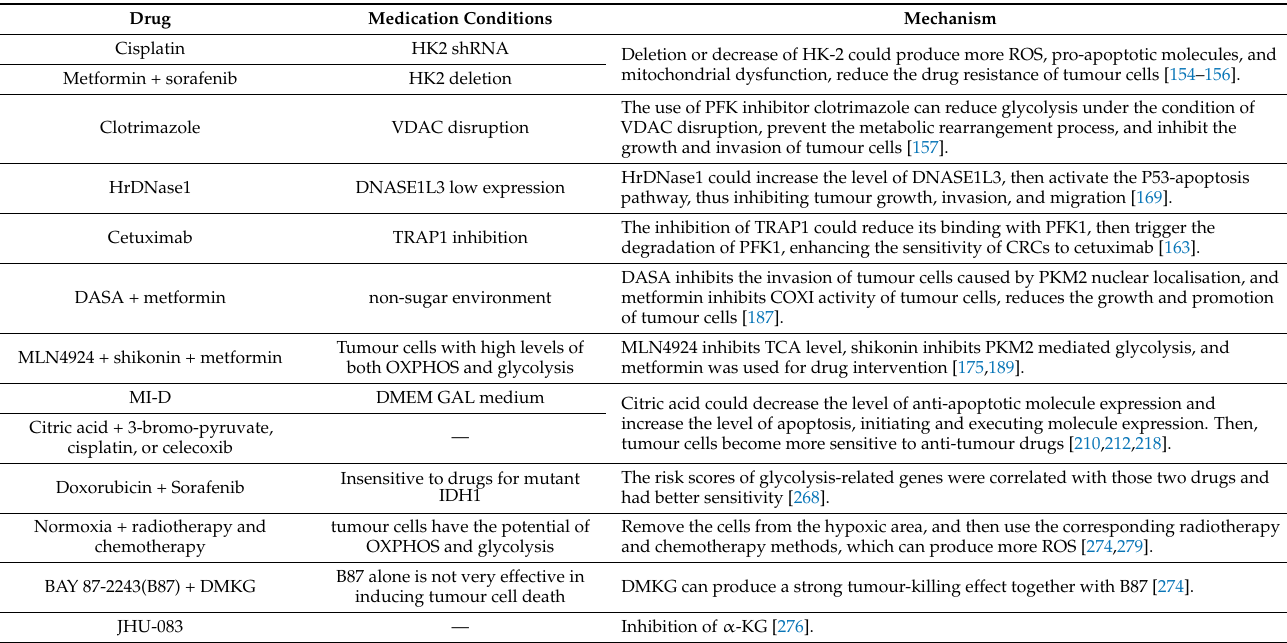
Table 1. Drug therapy for key enzymes that can cause metabolic remodeling.